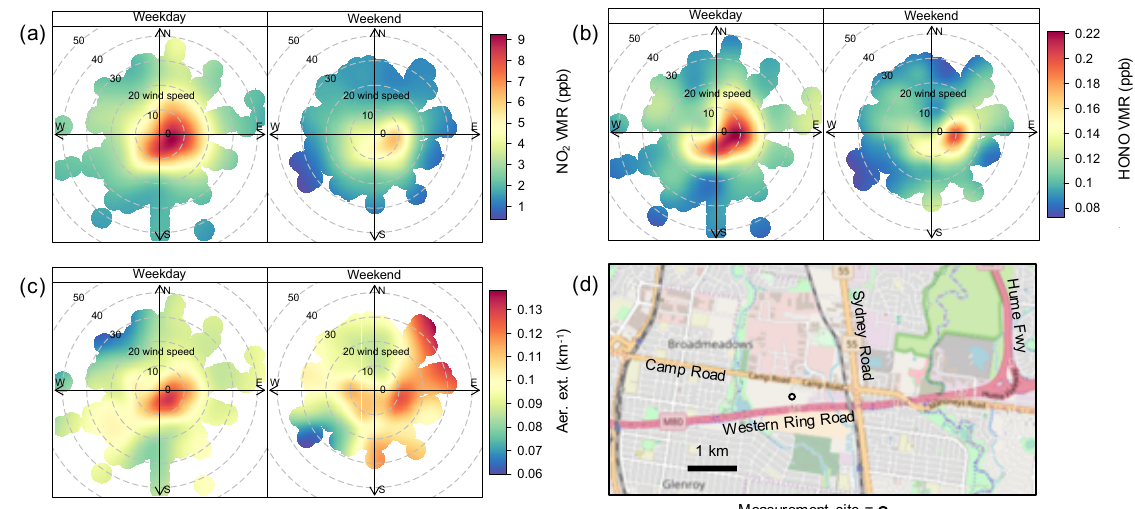
Figure 7. (a) Polar bivariate plot for average weekday (left) and weekend (right) NO 2 surface concentration as a function of wind speed and direction. (b) same as (a) but for HONO, (c) same as (a) but for aerosol extinction and (d) map indicating the location of the major road corridors near the measurement